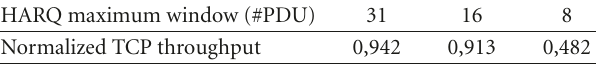
Table 1: HARQ sliding window versus TCP